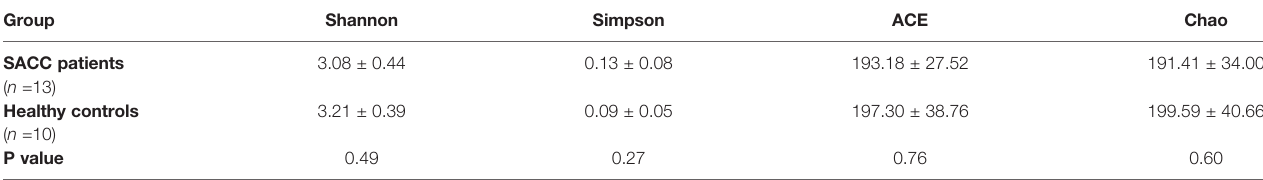
TABLE 2 | Alpha diversity indices.